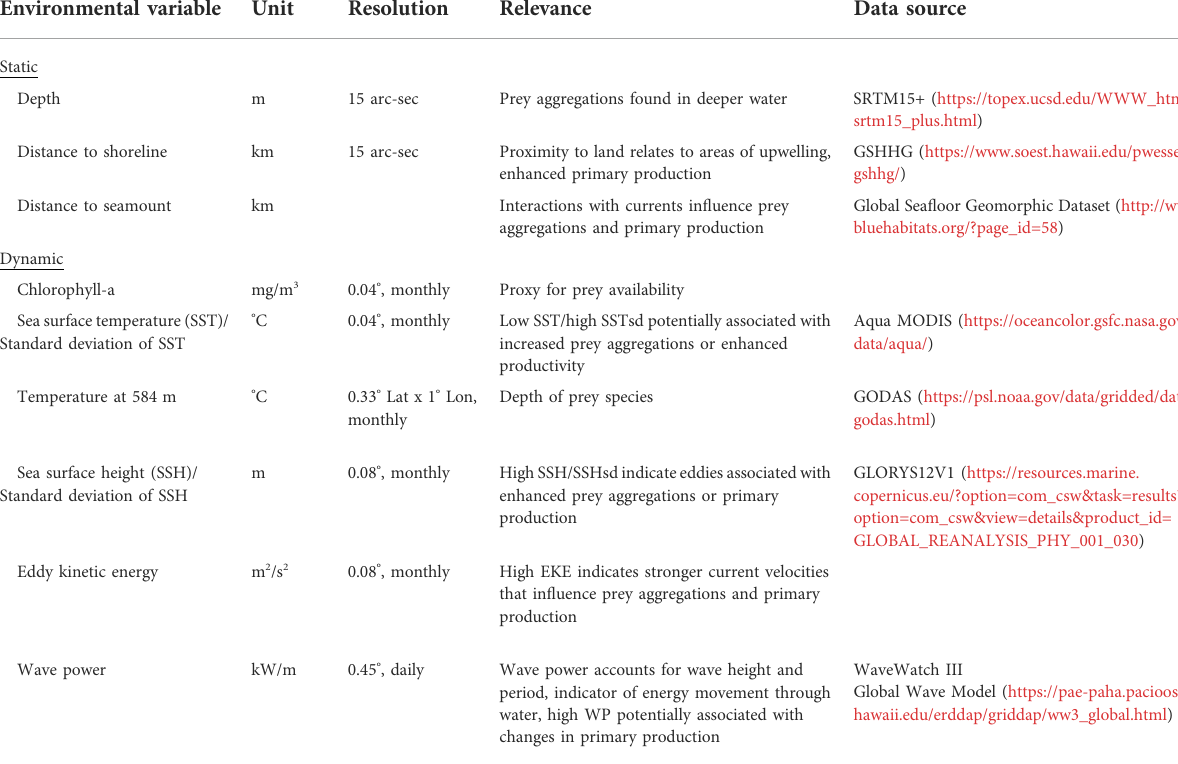
TABLE 3 Candidate environmental variables included as predictors for species distribution